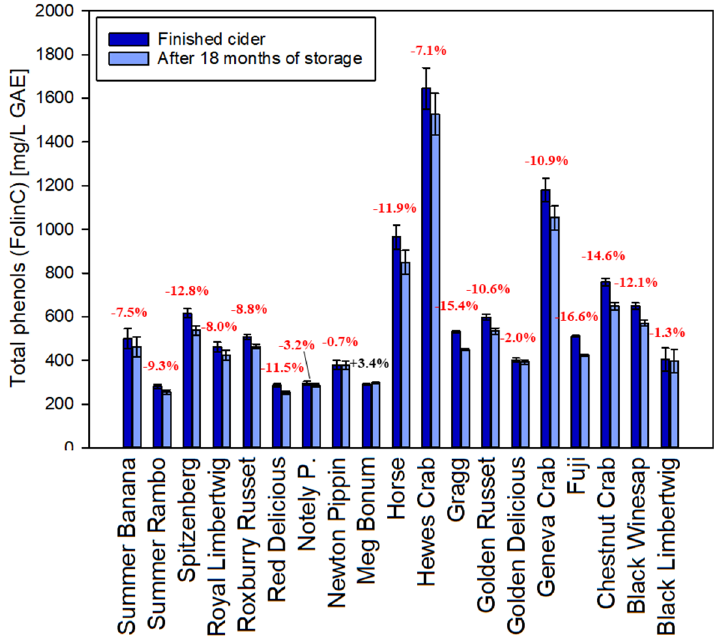
Figure 1. Comparison between total phenolics (Folin-Ciocalteu assay) in fresh apple cider and after 18 months of storage (GAE: Gallic acid equivalents). Error bars represent analytical standard deviation.